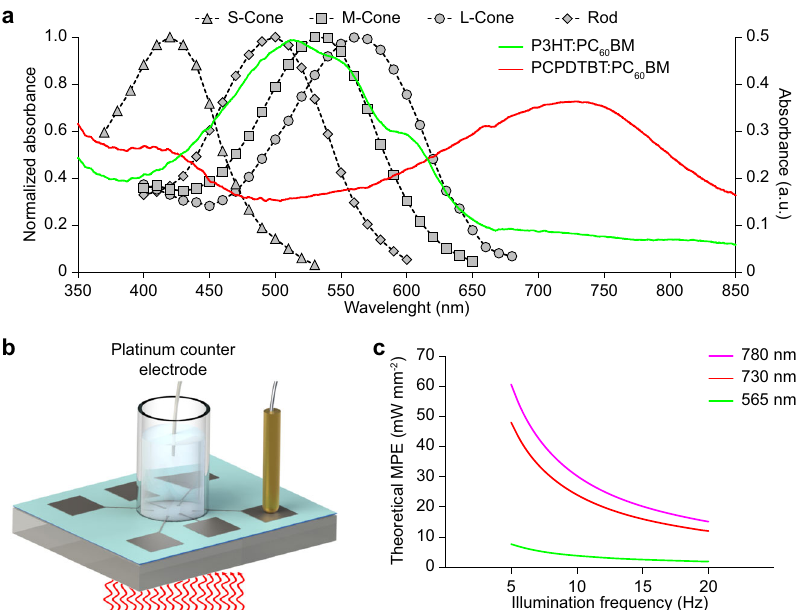
Fig. 1 Relevance of NIR illumination for organic photovoltaic retinal prostheses. a Normalized absorbance spectra of S-cones, M-cones, L-cones and rods on the left axis (redrawn from ref. 20 ). Absorbance spectra of the P3HT:PC 60 BM and the PCPDTBT:PC 60 BM BHJs on the right axis. b Sketch of the PC and PV recording setup. c Theoretical MPEs for 10-ms pulses as a function of the illumination